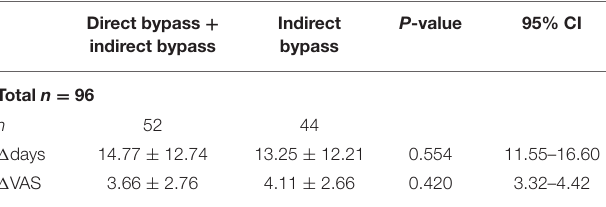
TABLE 6 | Intensity and frequency of headaches divided by different type of surgical revascularization(direct bypass + indirect bypass or indirect bypass) with changes in the frequency ( 1 days) and intensity of headaches ( 1 VAS) after revascularization surgery.